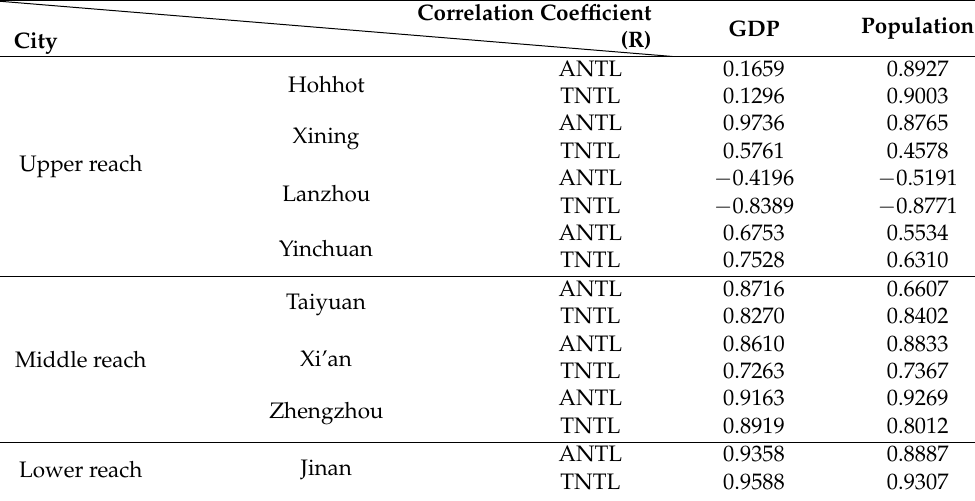
Table 3. Correlation analysis of TNTL and ANTL with GDP and population of urban built-up areas in the Yellow River Basin from 2013 to